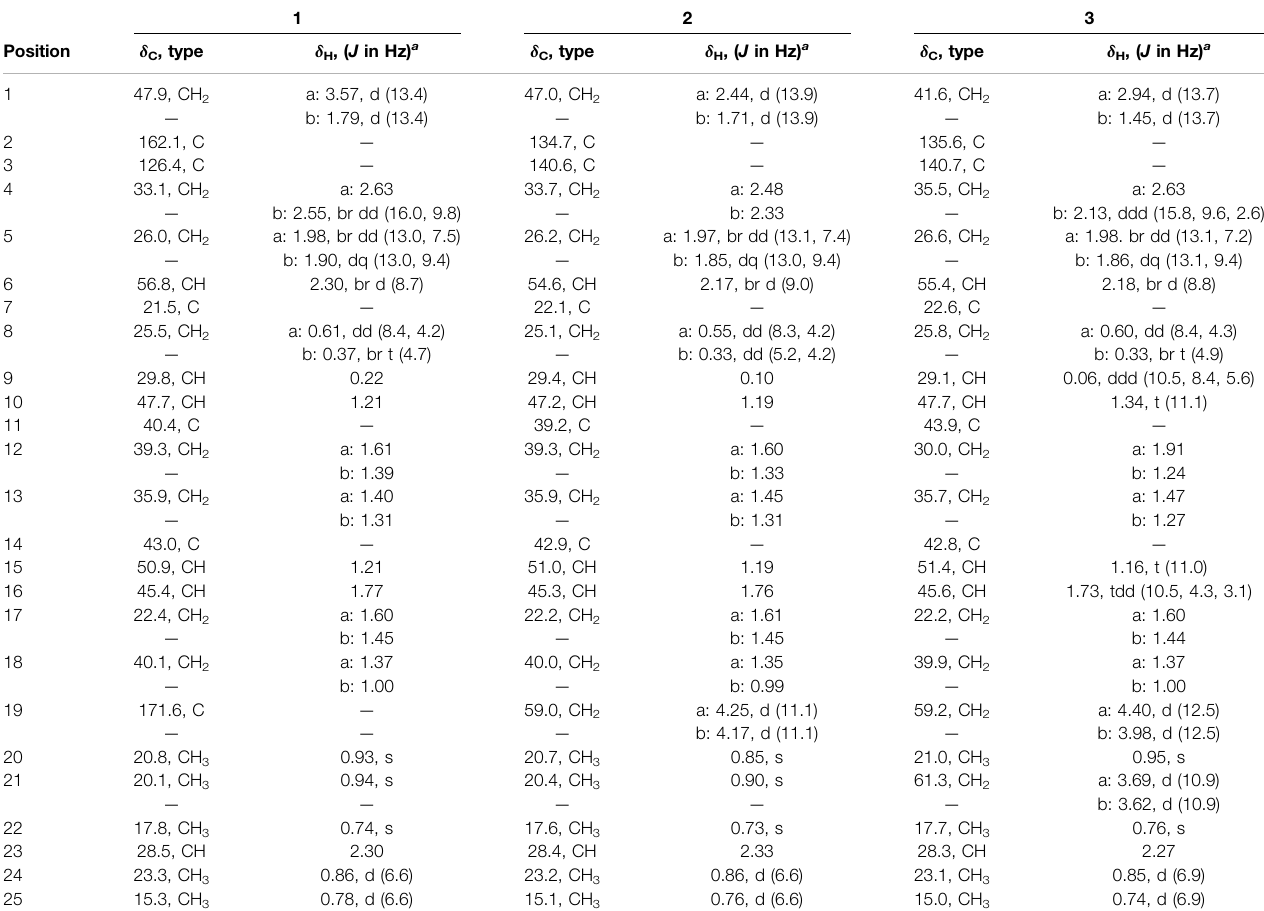
TABLE 1 | 1 H (600 MHz) and 13 C NMR (150 MHz) data of compounds 1 – 3 in CDCl 3